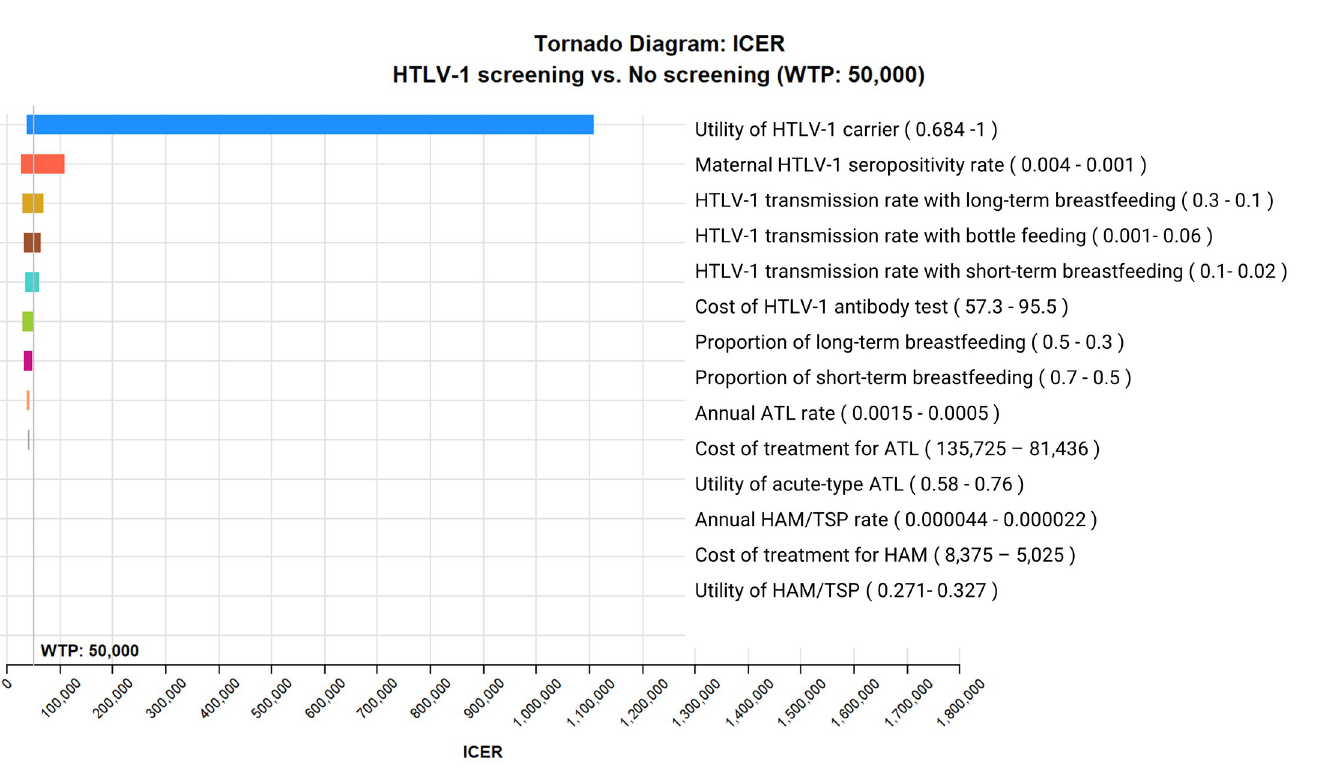
Fig 2. ICER tornado diagram for HTLV-1 antenatal screening versus no screening. HTLV-1 antenatal screening is cost-effective compared with no screening at a WTP threshold of US$50,000 per QALY gained when the maternal HTLV-1 seropositivity rate is greater than 0.0022, HTLV-1 transmission rate with long-term breastfeeding from HTLV-1 seropositive mothers to children is greater than 0.154, HTLV-1 transmission rate with short-term breastfeeding from HTLV-1 seropositive mothers to children is greater than 0.043, HTLV-1 transmission rate with bottle feeding from HTLV-1 seropositive mothers to children is lower than 0.044, the health utility value of HTLV-1 carriers is lower than 0.77, and the cost of HTLV-1 antibody test is lower than US$94.8. ICER, incremental cost-effectiveness ratio; WTP, willingness-to-pay; QALY, quality-adjusted life-year; HTLV-1, human T cell leukemia virus 1; ATL, adult T-cell leukemia-lymphoma; HAM/TSP, HTLV-1-associated myelopathy-tropical spastic